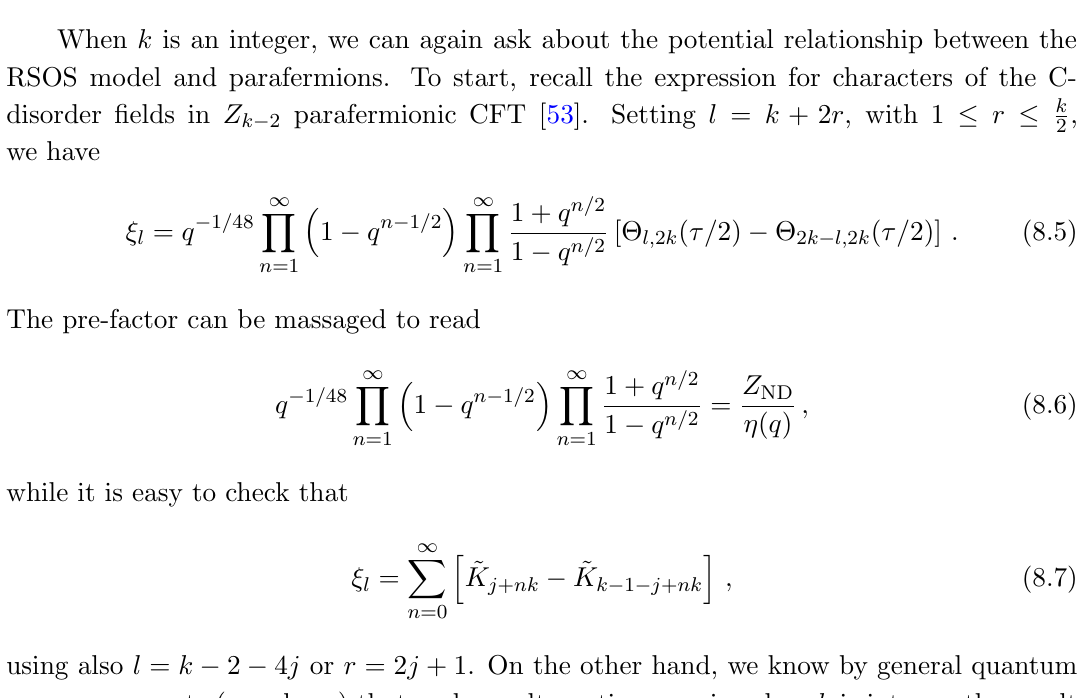
Figure 28 . The loop model with and odd number of strands. There must be at least one defect line running through the system when N is odd. We have N = 7 and j = 1 number of strands in the loop model corresponds to wired boundary conditions on one boundary in the Potts model: in this (cid:12)gure the wired boundary conditions are imposed on the right boundary: all Potts spins on the right boundary are identi(cid:12)ed, since they cannot be separated by any